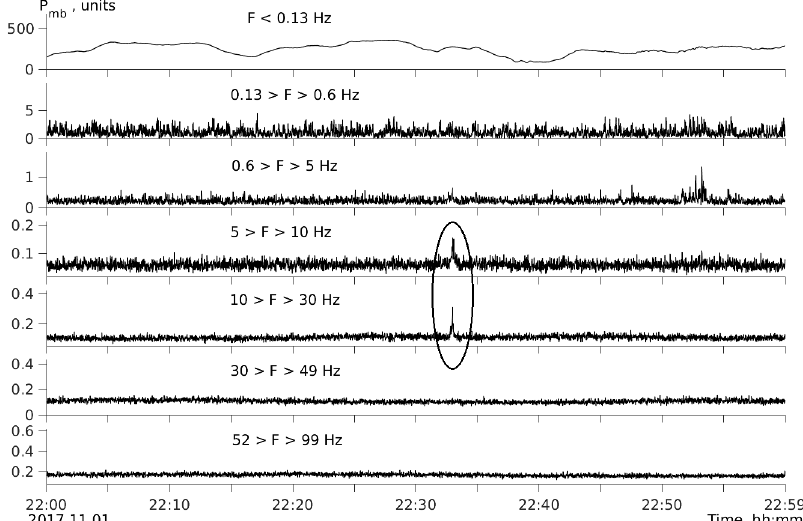
Figure 2: Atmospheric acoustic signal variations Pmb recorded by the microbarograph from 22:00 to 23:00 UT on November 1, 2017. Ellipse shows the amplitude pulse jump